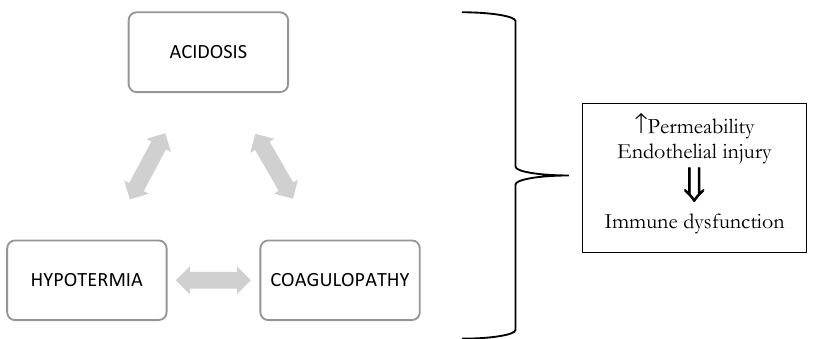
Figure 2. Virchow’s triad that interfere with the clinical course.